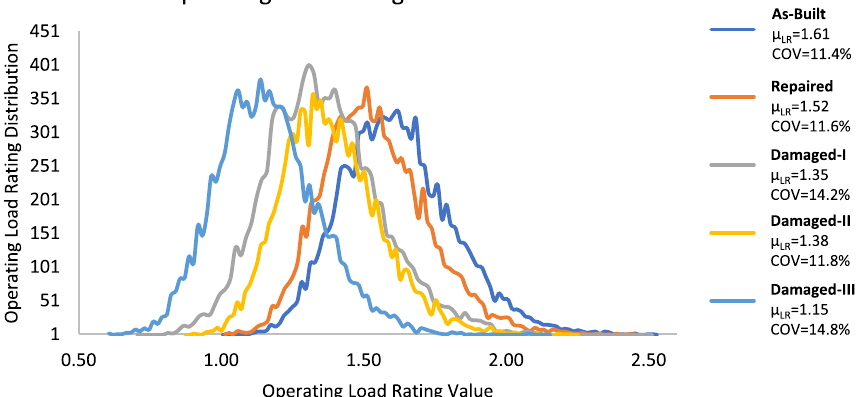
Fig. 13 The HL-93 operating load-rating distribution for all five the cases is in one chart. The mean operating load rating (µ LR ) and Coefficient Of Variation (COV) values are given for each case